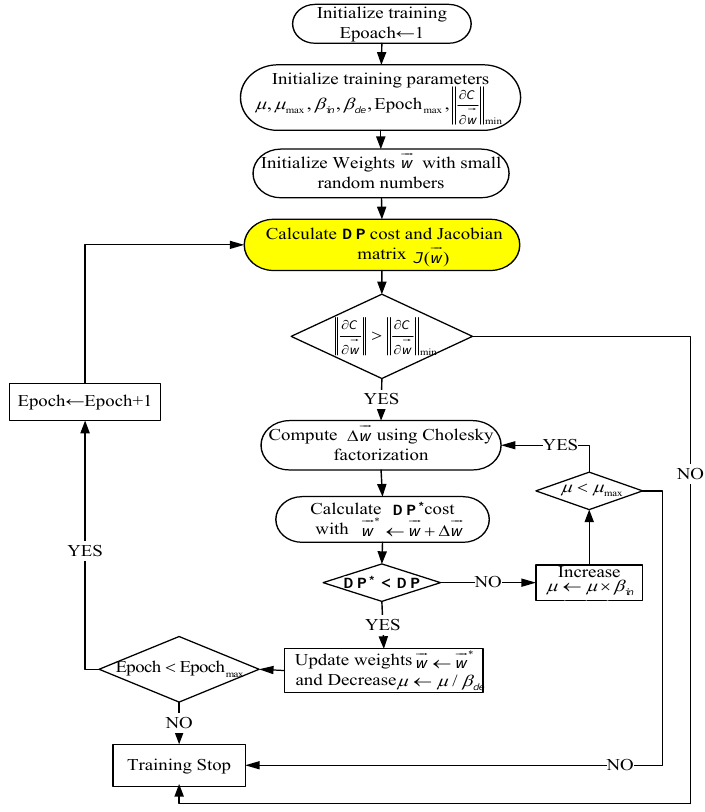
Figure 5. Levenberg–Marquardt (LM) algorithm for NN controller